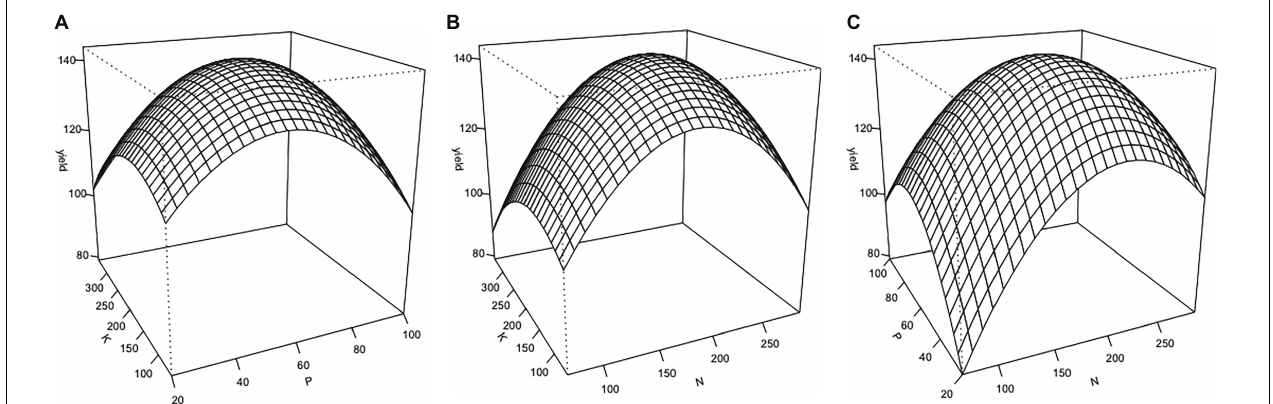
FIGURE 2 | Three-dimensional response surfaces for inflorescence yield (g/plant) at a range of nutrient solution N, P, and K concentrations (mg L − 1 ) of Cannabis sativa grown in deep water culture ( P ≤ 0.05, R 2 = 0.57). (A) Surface plot of K vs. P at N = 180 mg L − 1 . (B) Surface plot of K vs. N at P = 60 mg L − 1 . (C) Surface plot of P vs. N at K = 200 mg L − 1